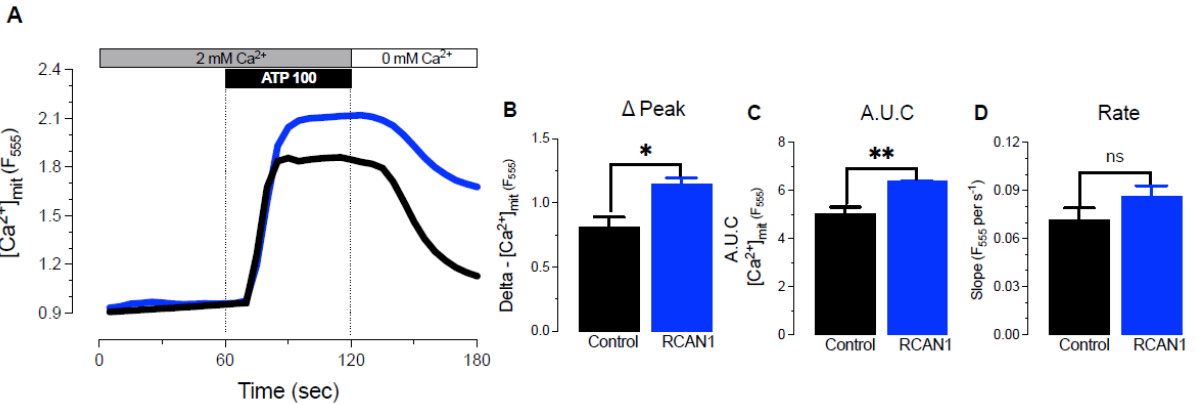
Figure 4. ( A ) Mitochondrial Ca 2+ uptake in control and RCAN1 overexpressing LS8 cells using Rhod-2AM after ATP (100 μM) stimulation. Black traces = control, blue traces = RCAN1. ( B – D ) Quantification of the ∆ peak of Ca 2+ influx, area under the curve (A.U.C), and Ca 2+ influx rate in control (black) and RCAN1 overexpressing (blue) LS8 cells. Data represent the mean ± SEM of three independent experiments analyzed by Student’s t -test. * p < 0.05, ** p < 0.01.